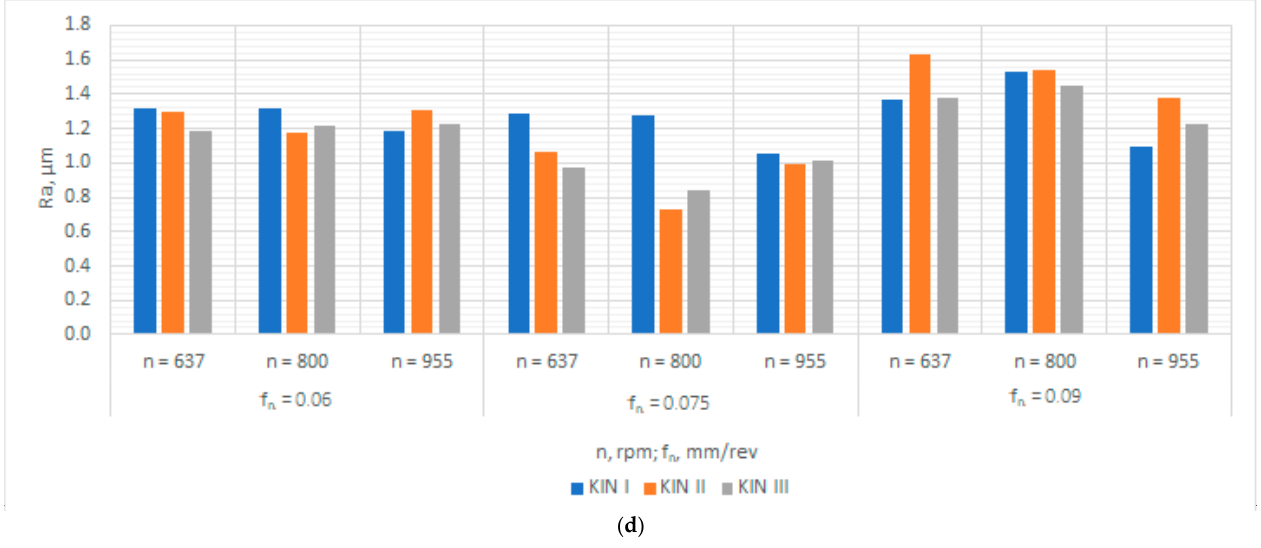
Figure 6. Graphical representation of the metrological analysis data for: ( a ) the cylindricity error; ( b ) the straightness error; ( c ) the diameter error; and ( d ) the parameter R a .